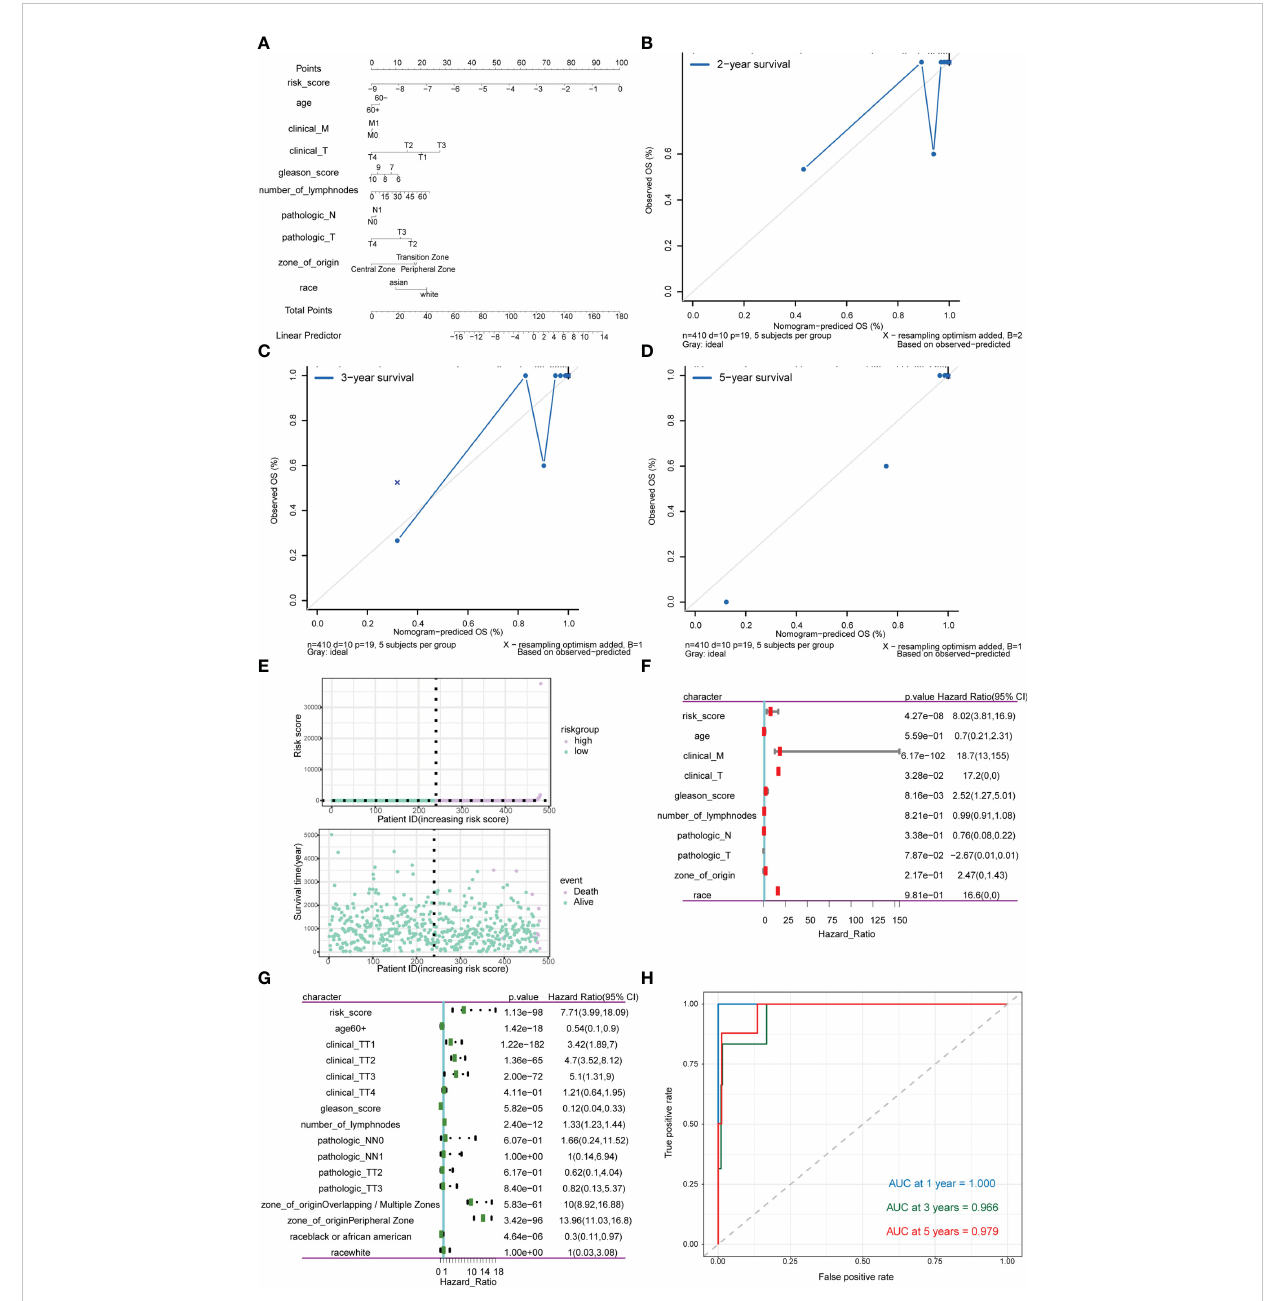
FIGURE 13 Analysis of the predictive power of risk scores for prognosis in PRAD patients. (A – D) Calibration curves of the nomogram. The horizontal axis is the survival predicted by the nomogram, and the vertical axis is the actual survival with repeated 1000 times each time. The curve shows the model had good predictive value of prognosis of patients for 2 years, 3 years and 5 years. (E) The risk group of the risk model. The horizontal axis shows the order of patient risk gradually increasing; the purple nodes represent patients with high-risk, the green nodes represent patients with low-risk, the vertical axis of the upper graph indicates the patient ’ s transformed risk score, and the vertical axis of the lower graph indicate survival time of patients. (F) HR and P values for risk scores by Univariate Cox regression analysis combined with clinicopathological features. (G) Multivariate Cox regression analysis of risk score combined with HR and P values of clinicopathological characteristics. The analysis showed that score of m 6 A group was an independent risk factor for the prognosis of PRAD patients. (H) Time-ROC curve of nomogram model for predicting 1-year survival,